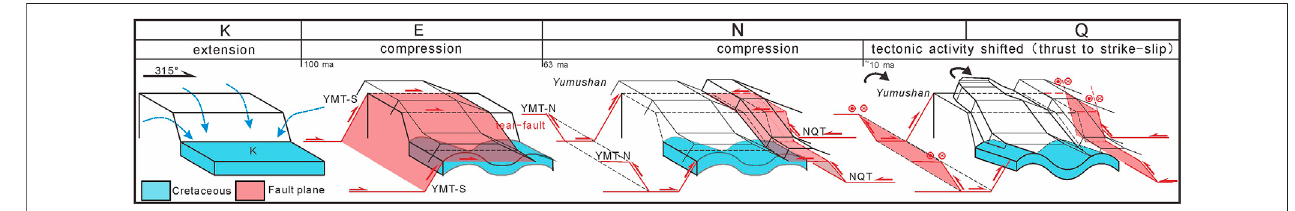
FIGURE12| Model ofthetectonic evolutionoftheSunan area(not strictly toscale). Cretaceous strata deformationhistoryofSunanBasin, fault planepropagation history, and kinematic characteristics of the strata block through time and tectonic activities, are